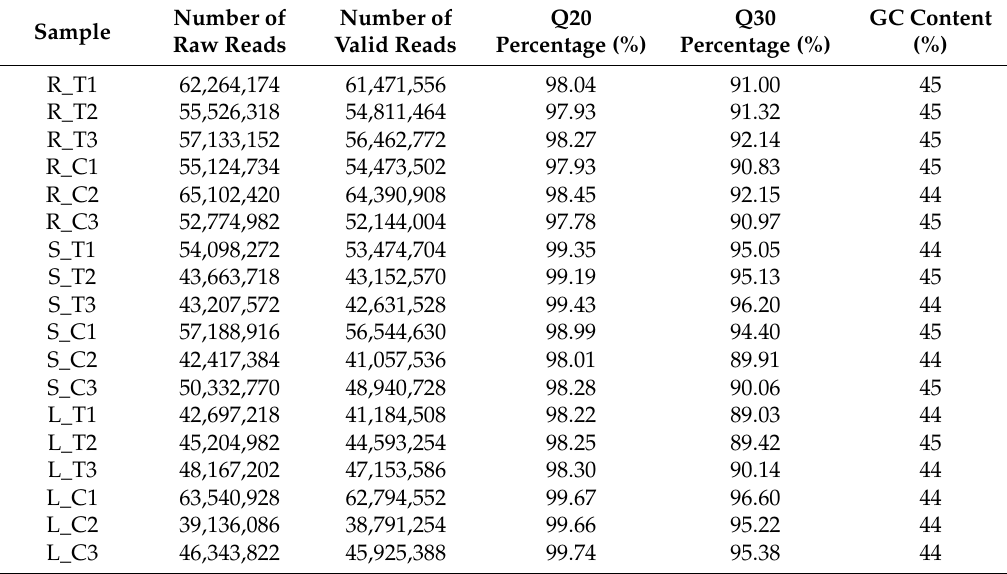
Table 1. Overview of the transcriptome sequencing of upland cotton. R_T1: Root Cd treatment 1,